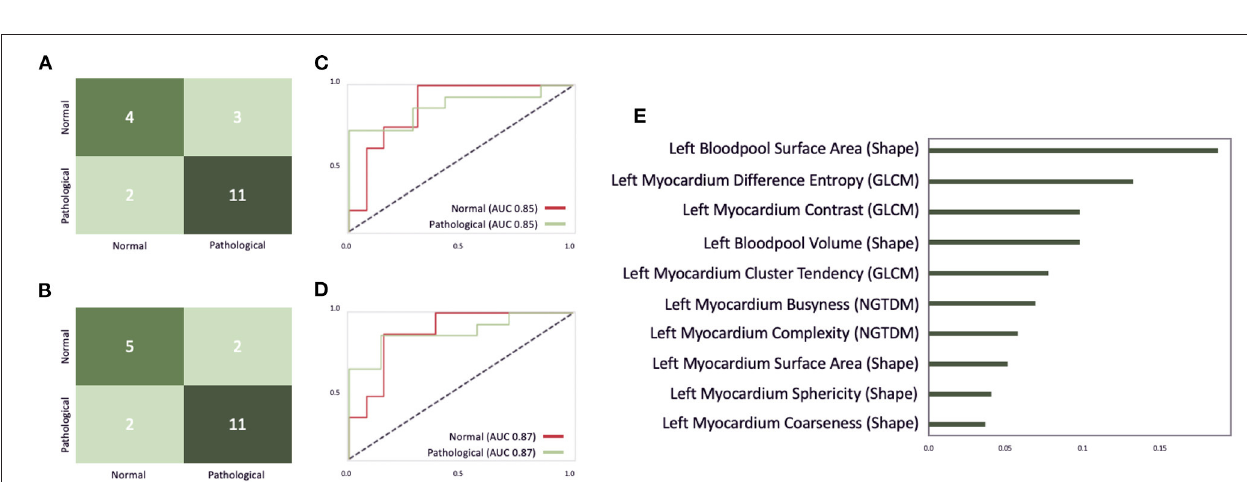
FIGURE 11 | An illustration of the EMIDEC classifier performance on the test dataset consisting of 20 cases. (A,B) Show the confusion matrix for the EMIDEC classifier before and after the correction of image segmentations via our described visual outlier detection. (C,D) Illustrate the AUC score before and after the correction. (E) Depicts the importance of the top 10 features for this